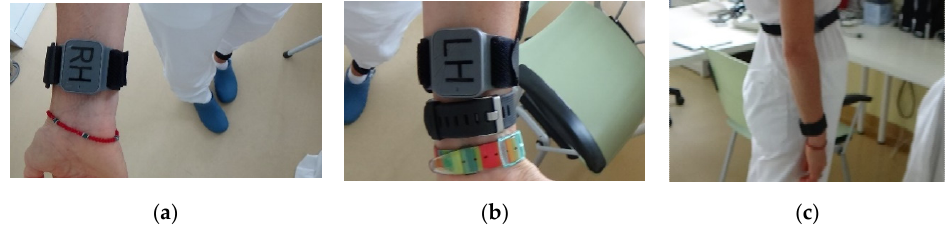
Figure 9. PDMonitor ® wrist-worn sensors attached against instructions, facing towards the torso when standing with hands down (ventral side): ( a ) Right Hand (wrist); ( b ) Left Hand (wrist); ( c ) side view.